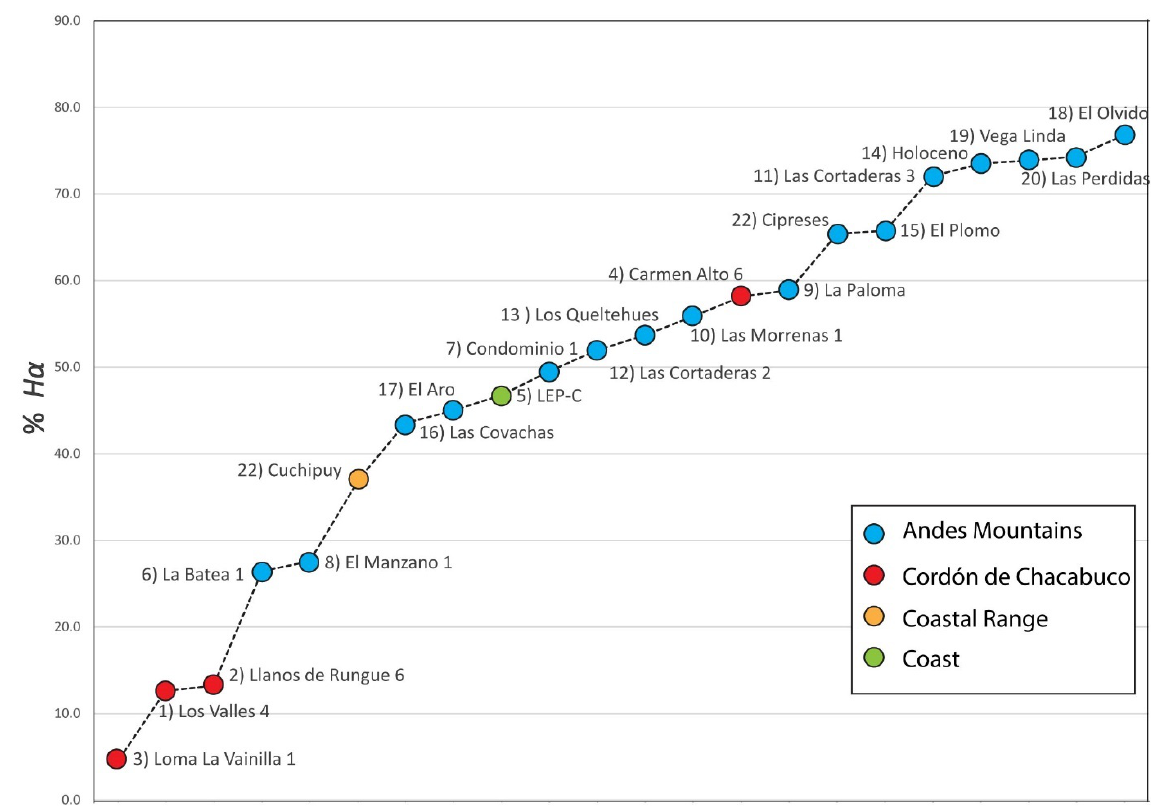
Figure 2. Distribution of the sites, by % of